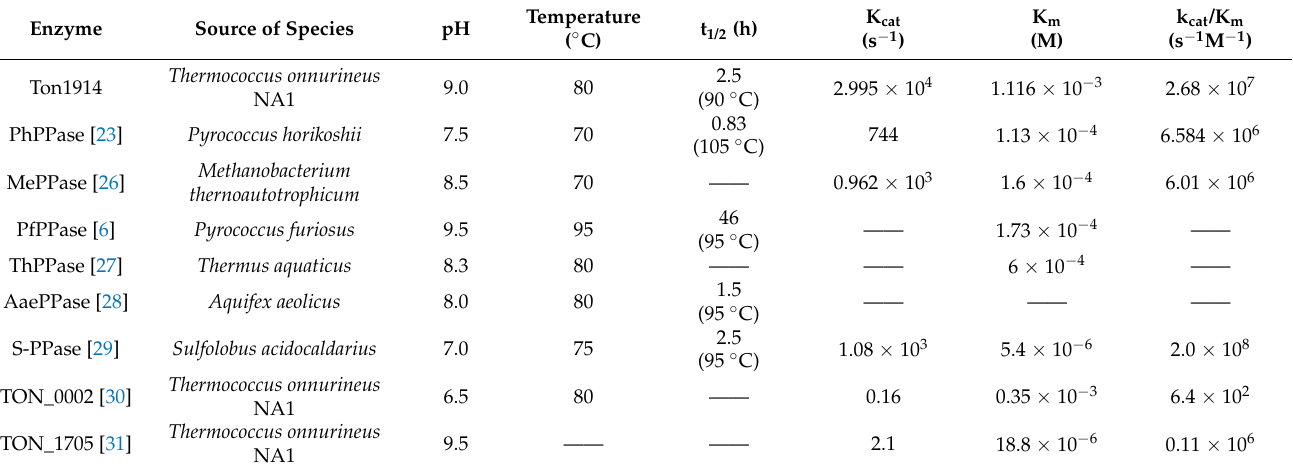
Figure 3. Stability of Ton1914. ( a ) The thermostability of Ton1914. The enzyme was incubated in Tris-HCl 9.0 at 70 ◦ C, 80 ◦ C, and 90 ◦ C for 75 h, 10 h, and 4 h, respectively; the inset is the result of 70 ◦ C, blue is at 80 ◦ C, and pink is at 90 ◦ C; ( b ) The stability of Ton1914 with Mg 2+ . The enzyme was incubated in Tris-HCl 9.0 containing 0 mM, 0.8 mM, 1.6 mM, and 2.4 mM Mg 2+ for five hours at 90 ◦ C. Samples were taken at hourly intervals for determining enzyme activity. The enzyme activity with 0 mM Mg 2+ for 0 h was set as 100%; ( c ) The pH stability of Ton1914. The enzyme was incubated in Tris-HCl with different pHs at 4 ◦ C. Table 1. Comparison of physicochemical properties of Ton1914 with other published pyrophos-